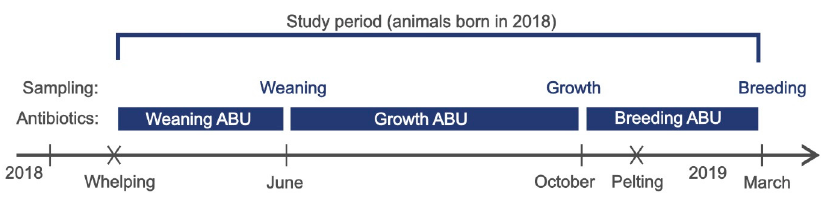
Figure 3. Timeline of the study and production cycle. Vertical lines indicate the sampling of animals and faeces. X indicates another important time point in the production periods: whelping in May and pelting in November. ABU: antibiotic use.